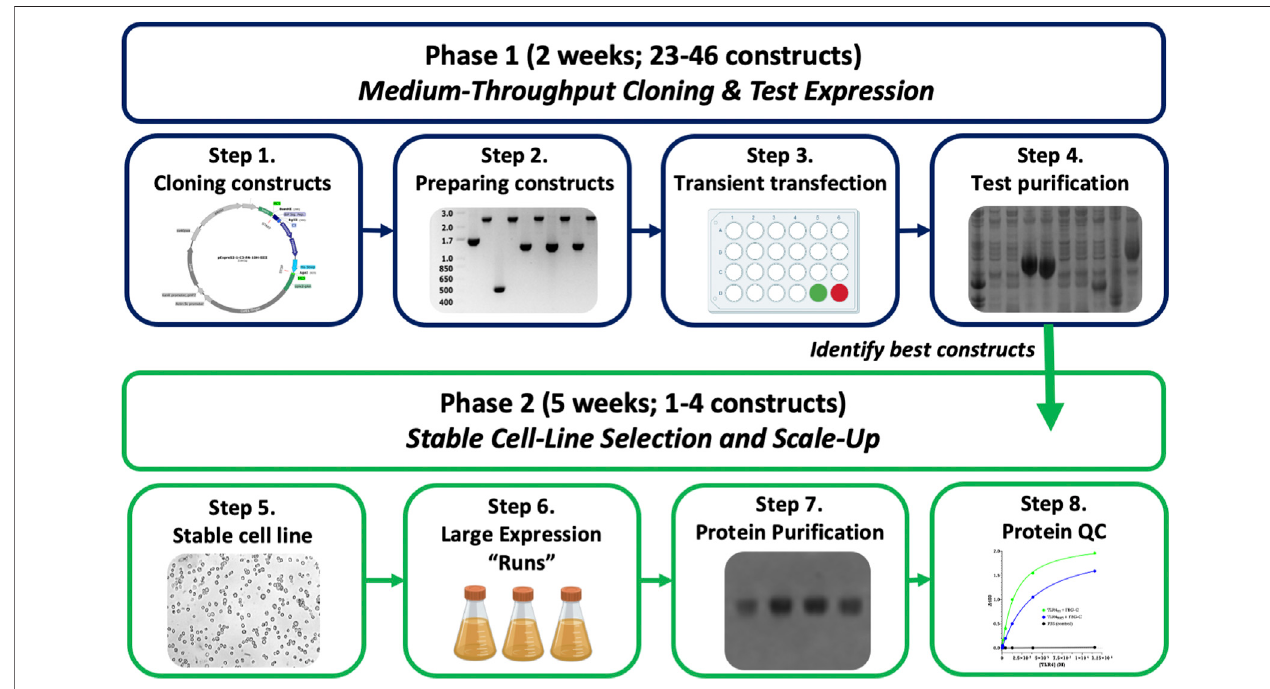
FIGURE 1 | Overview of the FAS2FURIOUS method. Step 1: constructs are designed and cloned into pExpreS 2 -1 class vectors using a HiFi assembly in 96-well plates. Step 2: insert-containing clones are veri fi ed by colony PCR and mini-prepped on spin-columns. Step 3: constructs are transiently transfected in parallel into S2 cells in 24-well plates. Step 4: supernatants are harvested, test-puri fi ed using 96-well fi lter plates, and checked for expression on SDS-PAGE. Step 5: polyclonal stable cell lines are selected using Zeocin for constructs of interest. Step 6: polyclonal cell lines are scaled up in 1L shake fl asks for large-scale puri fi